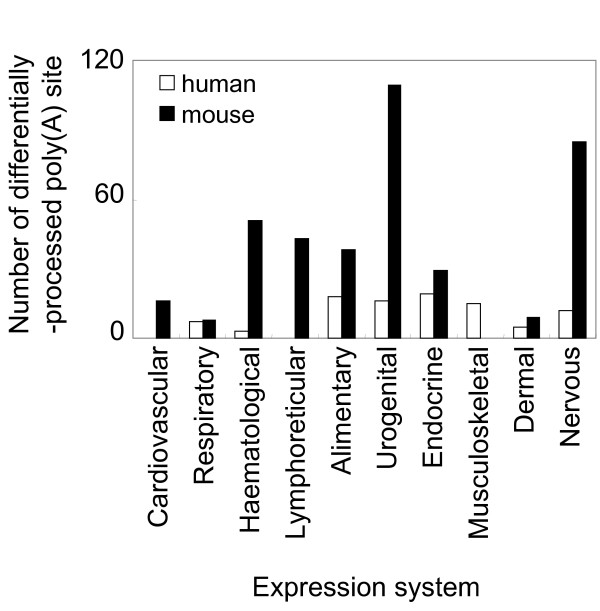
Tissue-distribution of differentially-processed, polyadenylation sites, in human (white) and mouse (black).